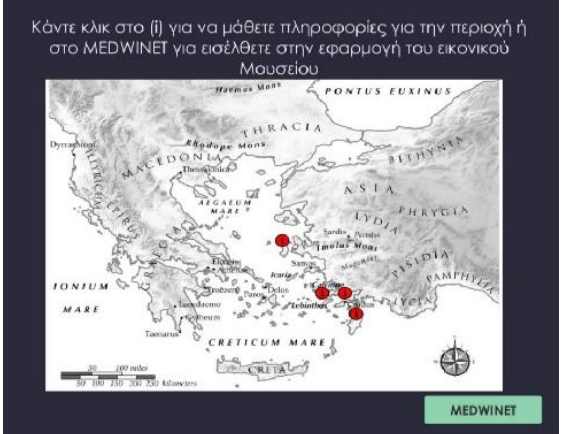
Figure 10. Map of the Aegean Sea